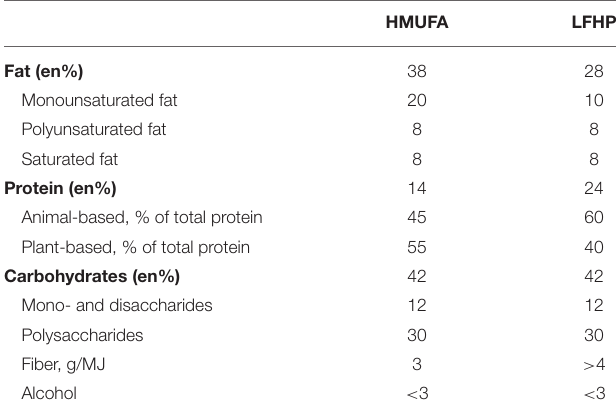
TABLE 1 | Targeted nutrient composition of the HMUFA and LFHP